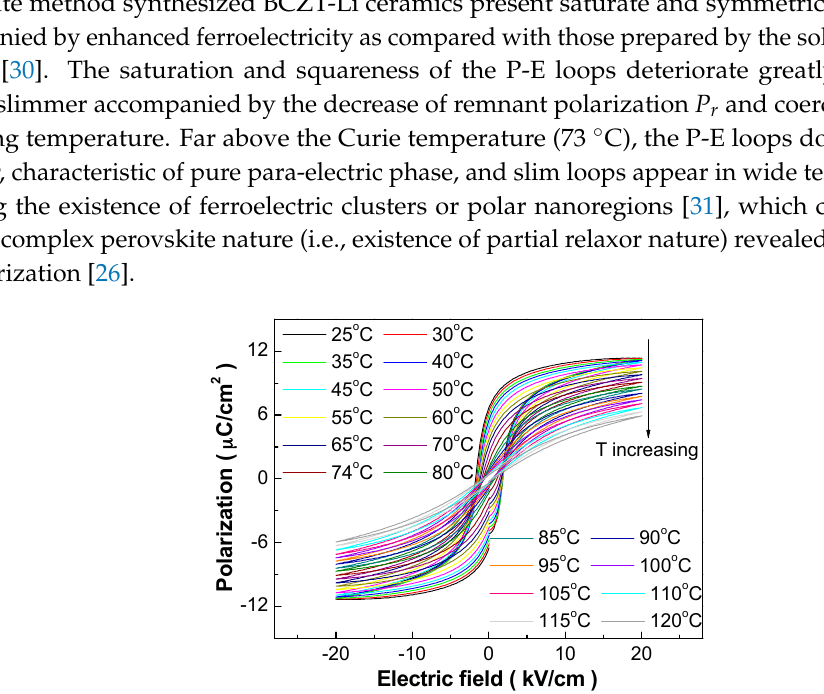
Figure 1. P-E hysteresis loops of the 1 wt % Li-doped (Ba 0.85 Ca 0.15 )(Zr 0.1 Ti 0.9 )O 3 (BCZT-Li) ceramics measured upon heating between 25 and 120 °C at 1 Hz and maximum electric field of 20 kV/cm.